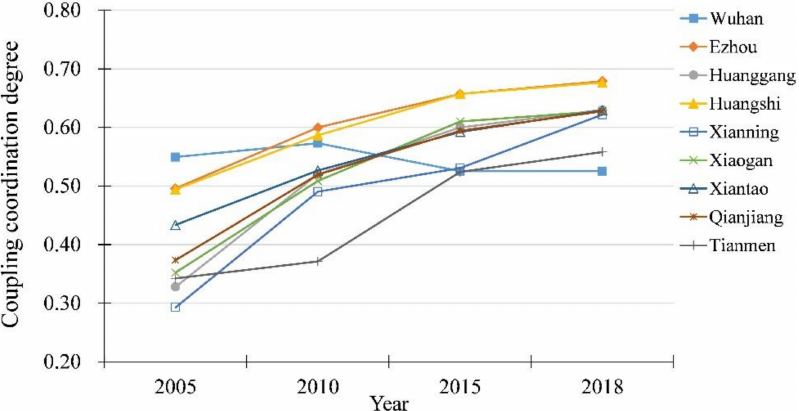
Figure 5. The changes of coupling coordination degree of urbanization and ecological